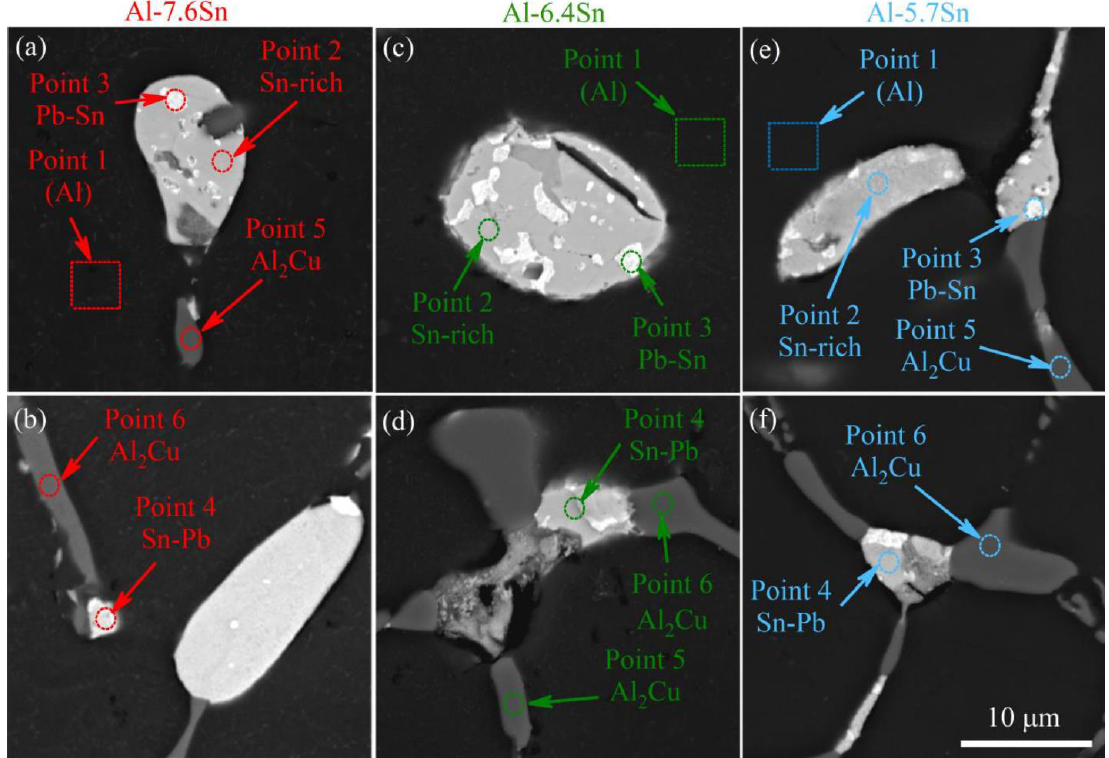
Figure 5. The BSE-SEM microstructures of the ( a , b ) Al-7.6Sn, ( c , d ) of the Al-6.4Sn, and ( e , f ) of the Al-5.7Sn alloys. The EDS spectra and chemical compositions of the analyzed points are presented in Figures S1 – S3 in Supplementary data.